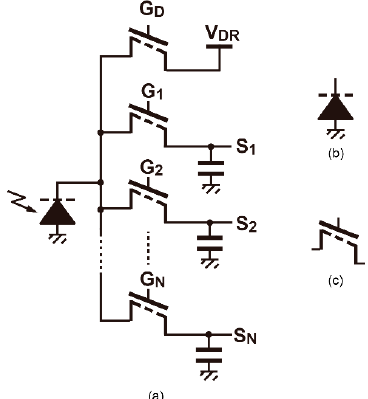
Figure 1. Conceptual schematic of multiple-tap lock-in pixels: ( a ) N-tap lock-in pixel with a drain, ( b ) symbol for a depleted photodiode, and ( c ) symbol for a modulation gate.